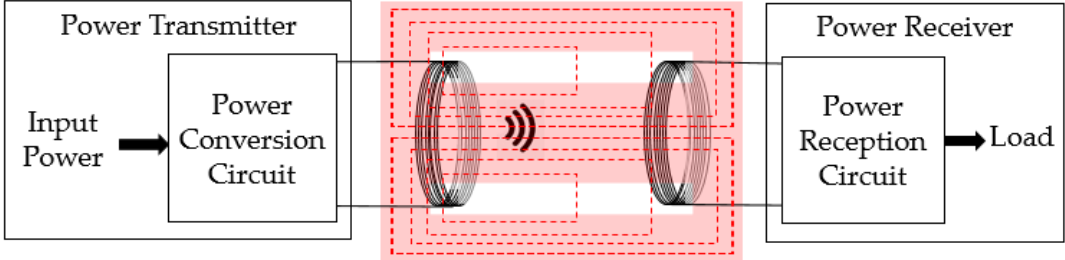
Figure 1. The basic principle of transferring electric energy over the air.